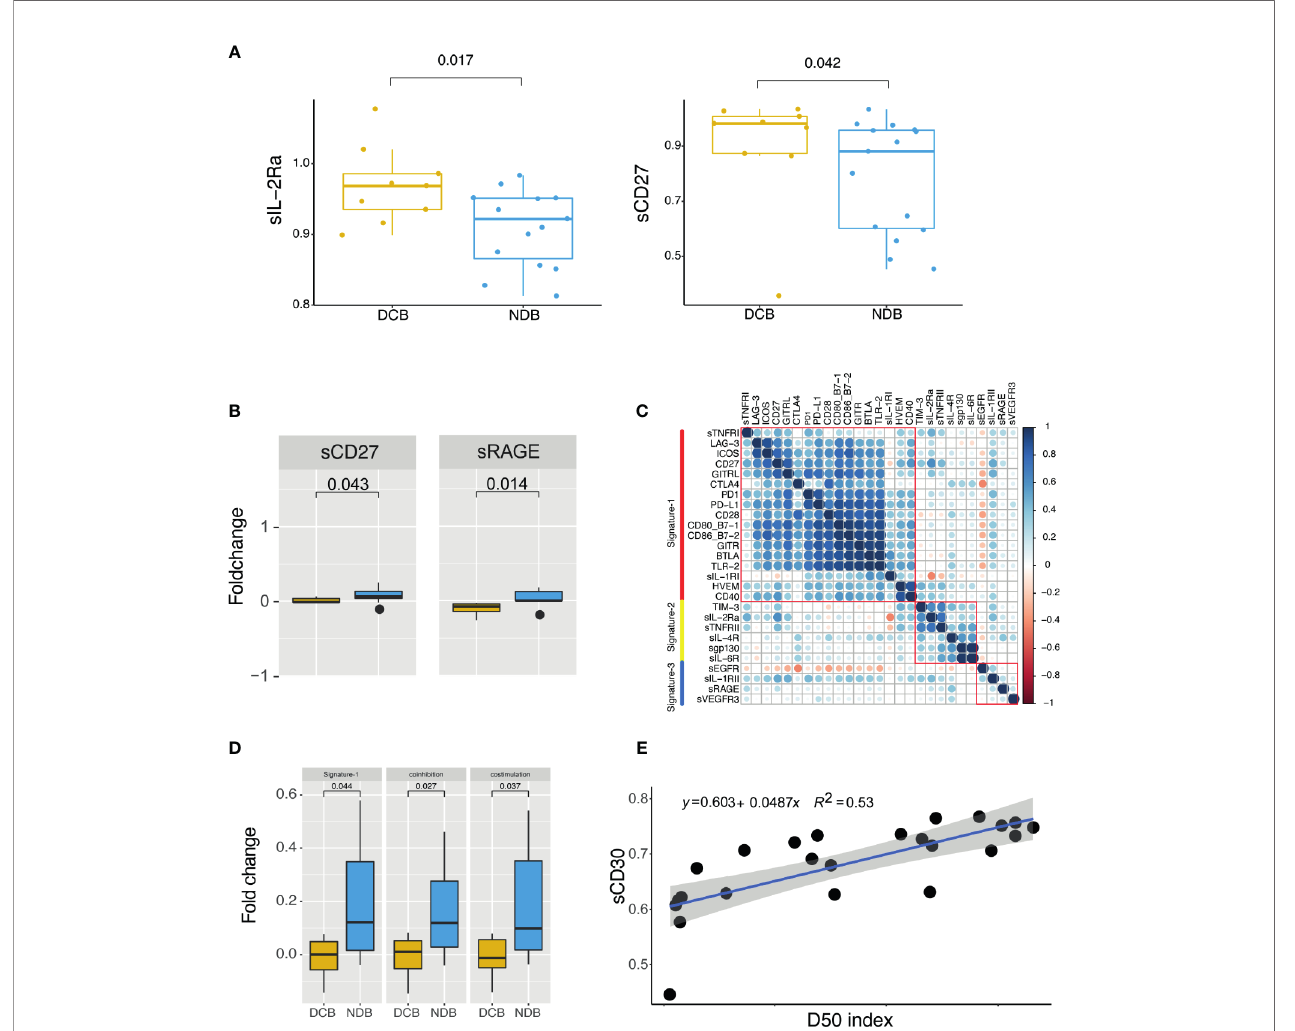
FIGURE 4 | Peripheral soluble receptors and ligands landscape and therapeutic outcome. (A) Different expression of soluble receptors and ligands between clinical bene fi t groups at baseline. (B) Dynamic changes of sCD27 and sRAGE compared between clinical bene fi t groups. (C) Correlation map of dynamic changes in soluble cytokine receptors and immune checkpoint protein expression. Correlations were de fi ned using paired person correlation. (D) Signature-1 genes were differently expressed between clinical bene fi t groups. (E) Correlation between D50 index and sCD30. Statistical analysis of (A, B, D) was performed using the Mann-Whitney test. Boxes depict the interquartile range with the line in boxes showing the median, and the lines outside the boxes showing the fi rst or third quartiles of